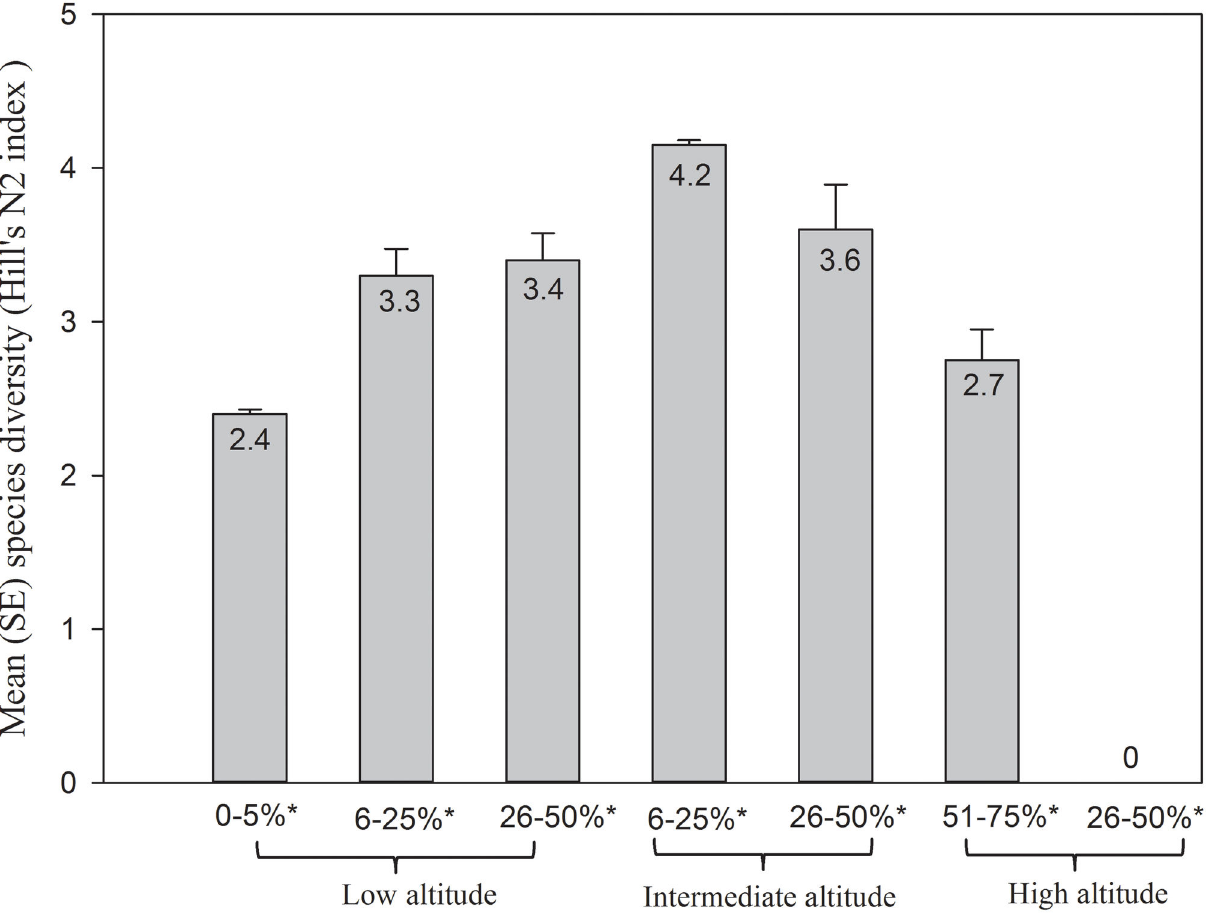
Figure 3. Pattern of lizard species diversity (Hill's N2 index) in relation to overall plant density (percentage with star) and elevation in the Qom Province of Iran. Low elevation <1100 m, medium elevation 1101-1800 and high elevation >1801 m. doi: